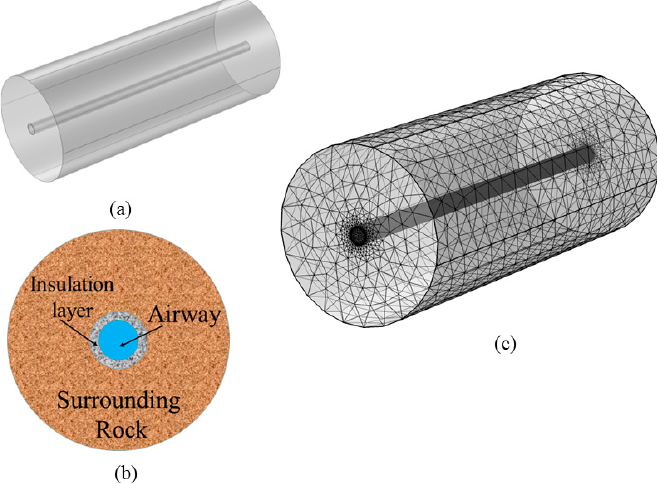
Figure 13. Geometric model: ( a ) Three-dimensional stereo view. ( b ) Cross-section. ( c ) Meshing.